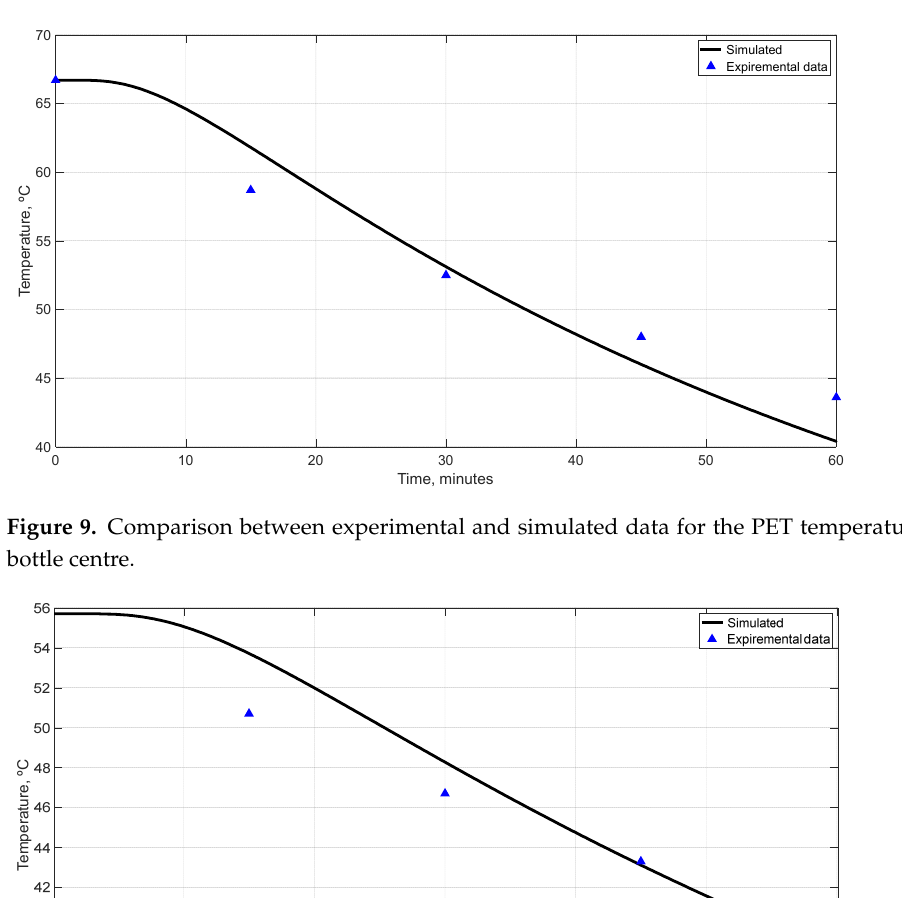
Figure 8. Comparison between experimental and simulated data for the Al 319 temperature at the bottle centre.